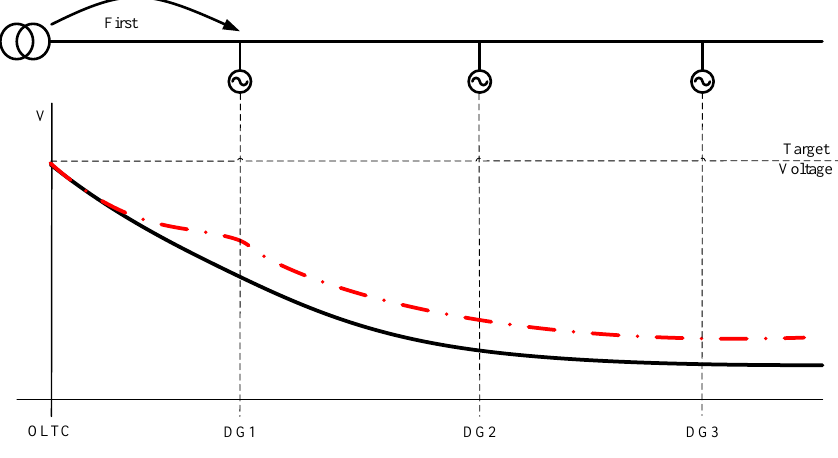
Figure 5. Voltage profile by reactive power of DG 1.